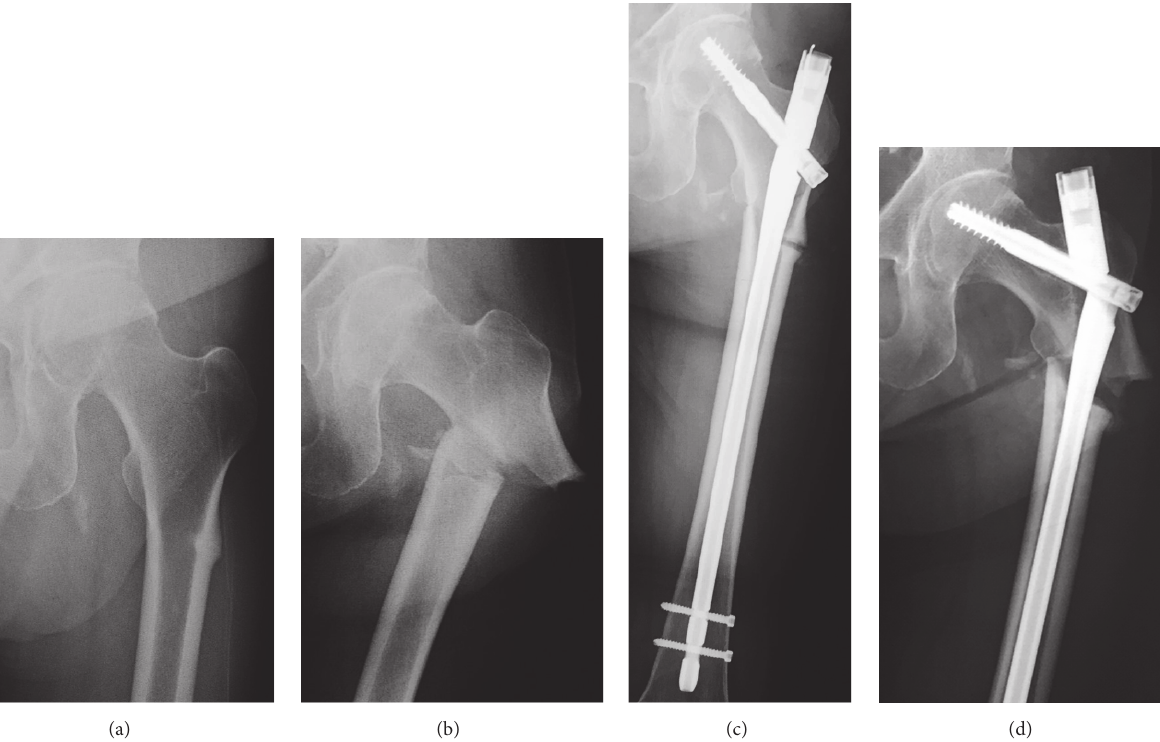
Figure 1: (a) An AP radiograph of the left femur shows a transverse fracture line and thickening of the lateral cortex at the subtrochanteric area. (b) A completely displaced fracture. (c) The internal fixation using a long femoral nail. (d) The nail breakage and opening of the fracture